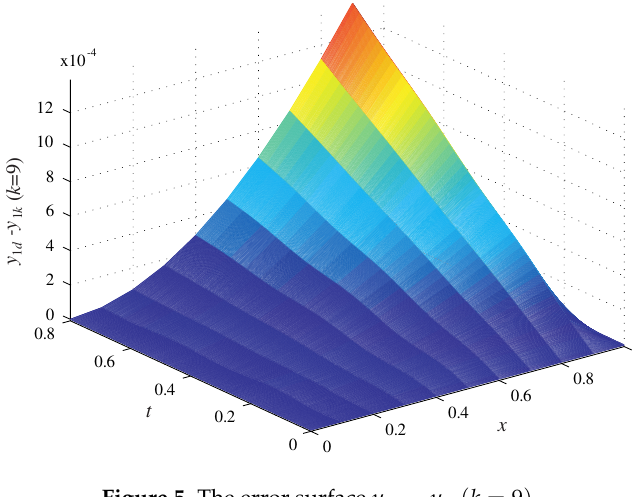
Figure 5. The error surface y 1 d − y 1 k ( k = 9 ) .